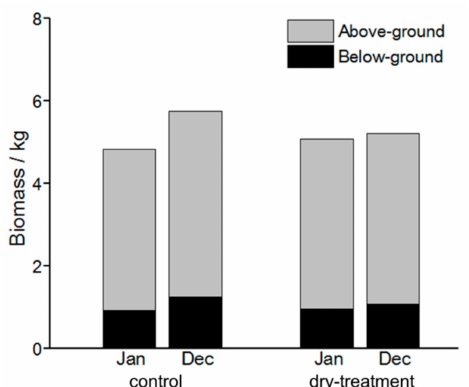
Figure 8. Simulated above- and below-ground biomasses for trees of the control and treatment groups for the entire year 2017.